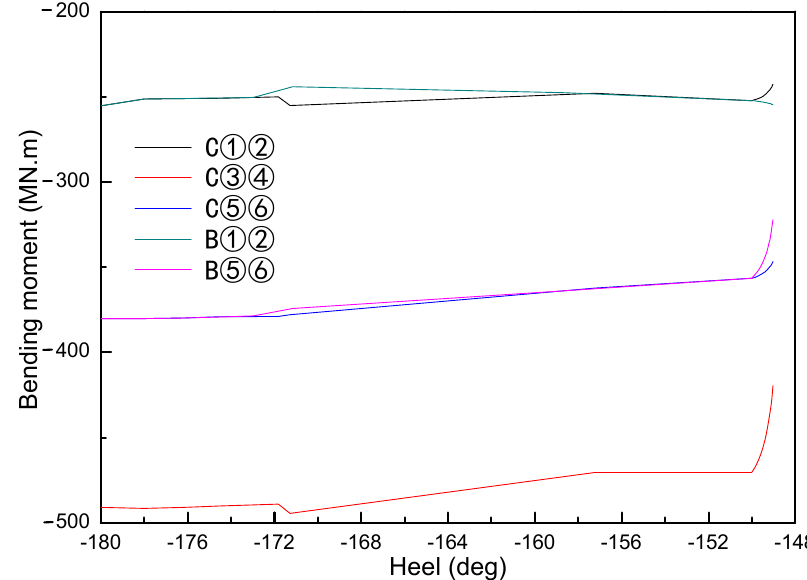
Figure 8. Variation of bending moment under case Ⅱ .